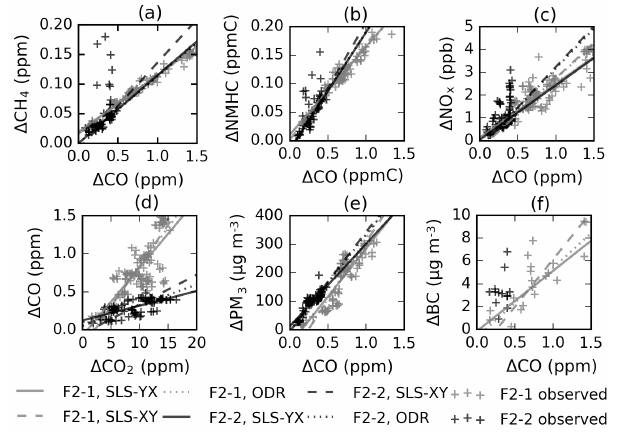
Figure 6. Same as Fig. 5 but for F2 plume